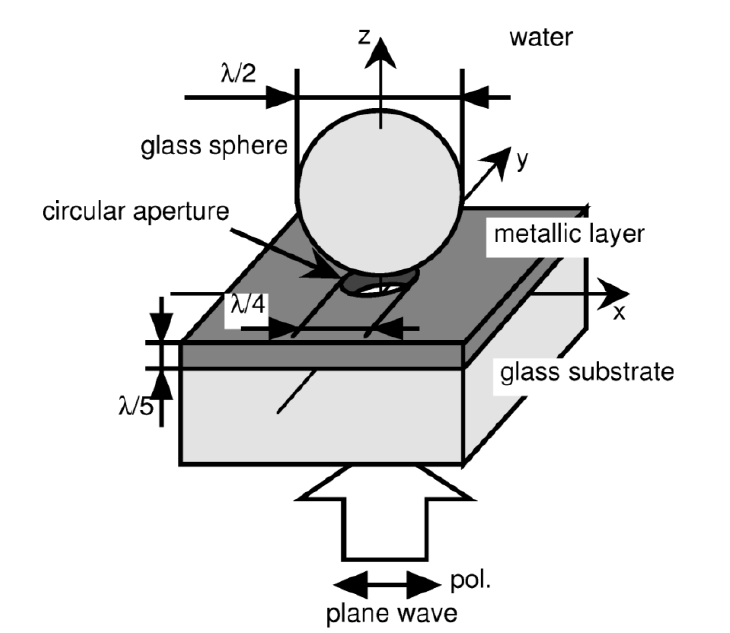
Figure 5. The geometrical model, studied by Okamoto et al., for subwavelength particle trapping, utilising the evanescent field near a metallic nano-aperture. This is the most commonly studied and reported geometry due to its simplicity to fabricate using the focussed ion beam (FIB) milling technique. Figure reproduced with permission from